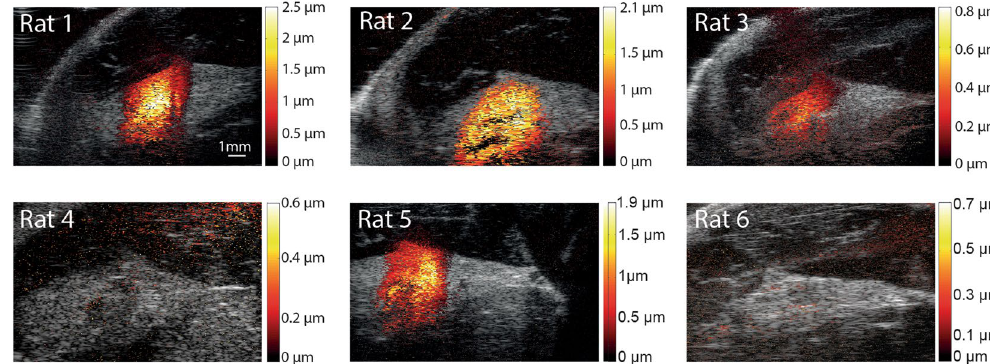
Figure 3. Magnetomotive ultrasound images of the sentinel lymp node and its surrounding fat capsule in all six animals. The images for animal 1, 2, 3 and 5 were obtained at an electromagnet exitation voltage of 40 V 5 Hz whereas the images for animal 4 and 6 were obtained at 60 V 5 Hz. The higher voltage setting is shown since no detectable magnetomotive displacement was found in animal 4 and 6. For animal 1, 2, and 5 bleeding of the magnetomotive signal outside the sentinel lymph node and fat capsule occurred in the MMUS images for the 60 V setting. This make the images difficult to compare, thus the 40 V setting is presented. The colour represents magnetomotive displacement according to the colour-bars to the right.